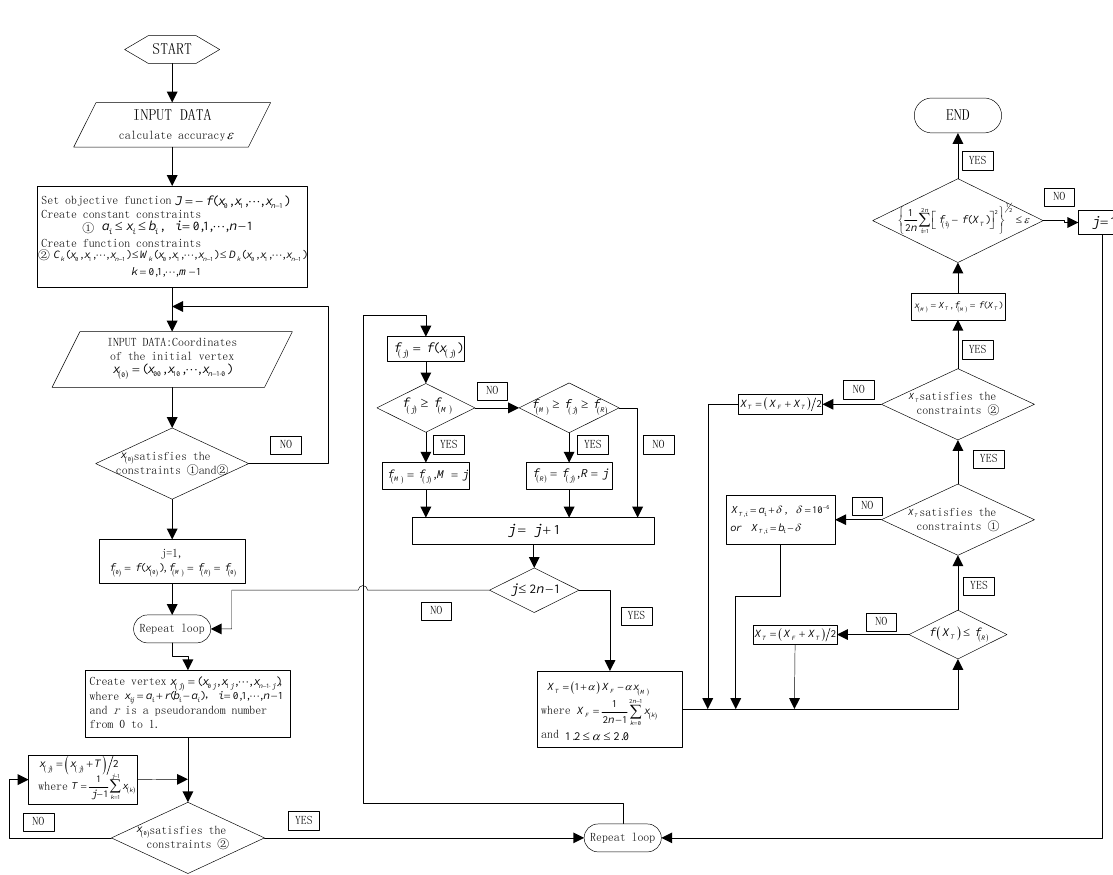
Figure 7. Flow chart for the Nelder-Mead method under constraint conditions.